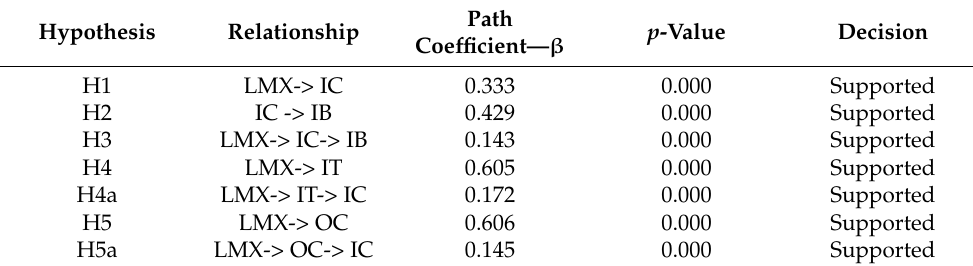
Table 5. Path coefficients—direct and indirect